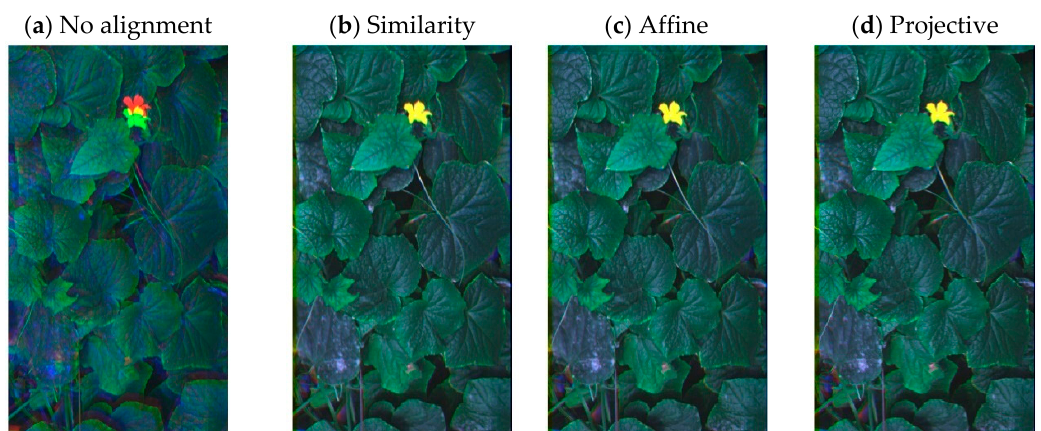
Figure 11. Comparison of the RGB composite created with the MicaSense ® RedEdge blue, green, and red band images acquired at close range over cucumber plants. The image registration was achieved using the following geometric transformation ( a ) no registration, ( b ) similarity, ( c ) affine, ( d ) projective.